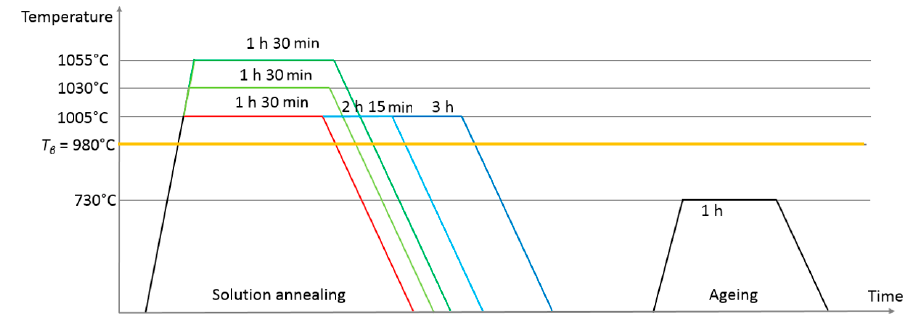
Figure 4. Heat treatments performed.